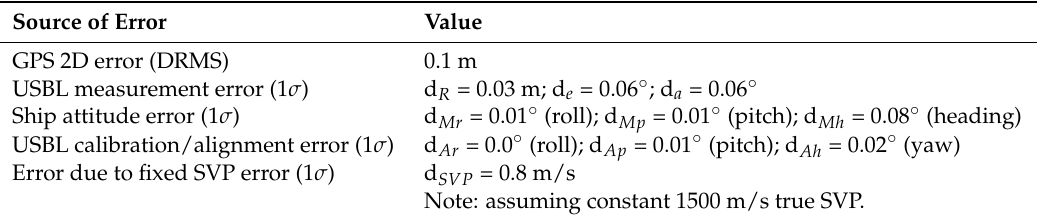
Table 12. Estimated position uncertainties due to surface ship